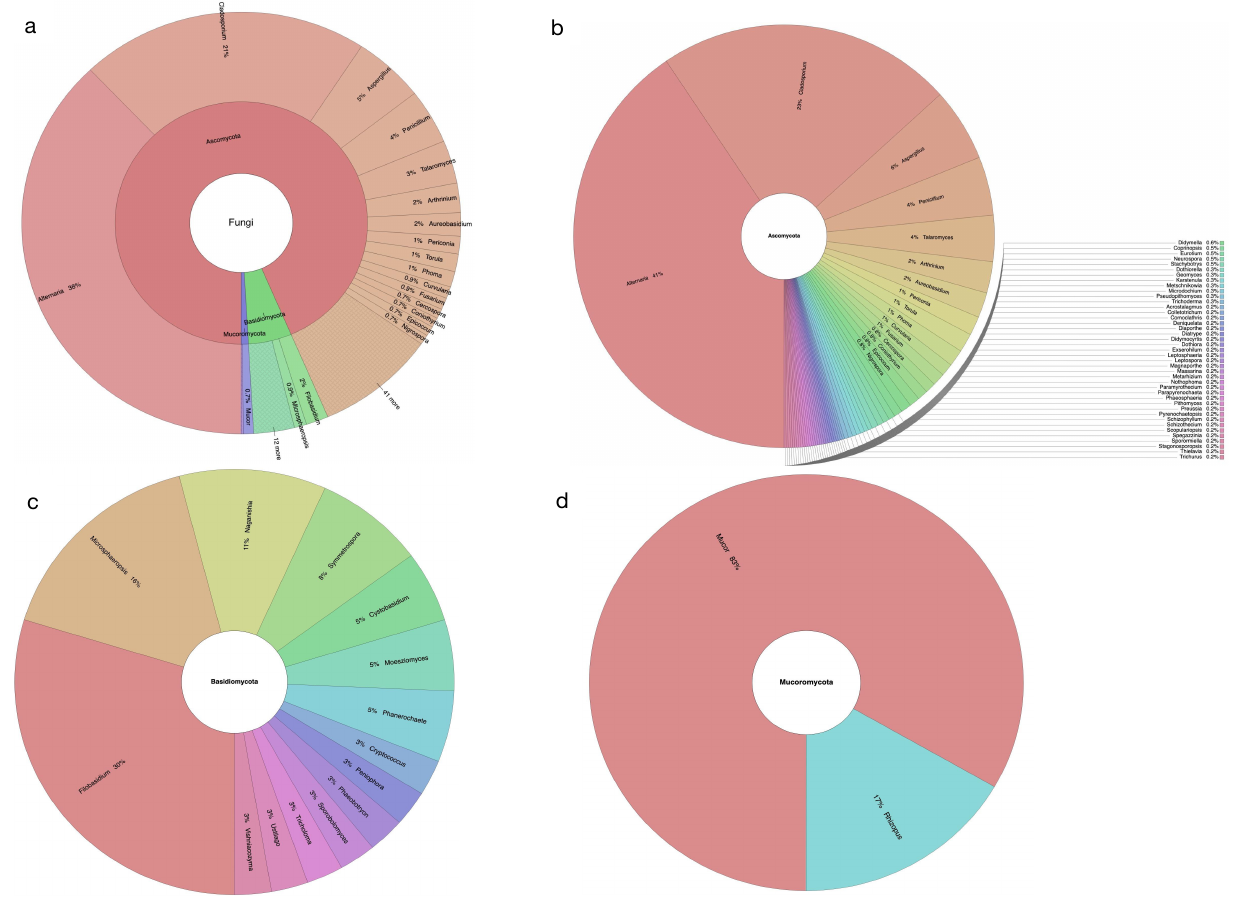
Figure 2. The taxonomic identification and relative abundance of airborne fungi isolated from the building 24. ( a ) Total fungi overview, ( b ) detailed separated view of Ascomycota, ( c ) Basidiomycota, and ( d )